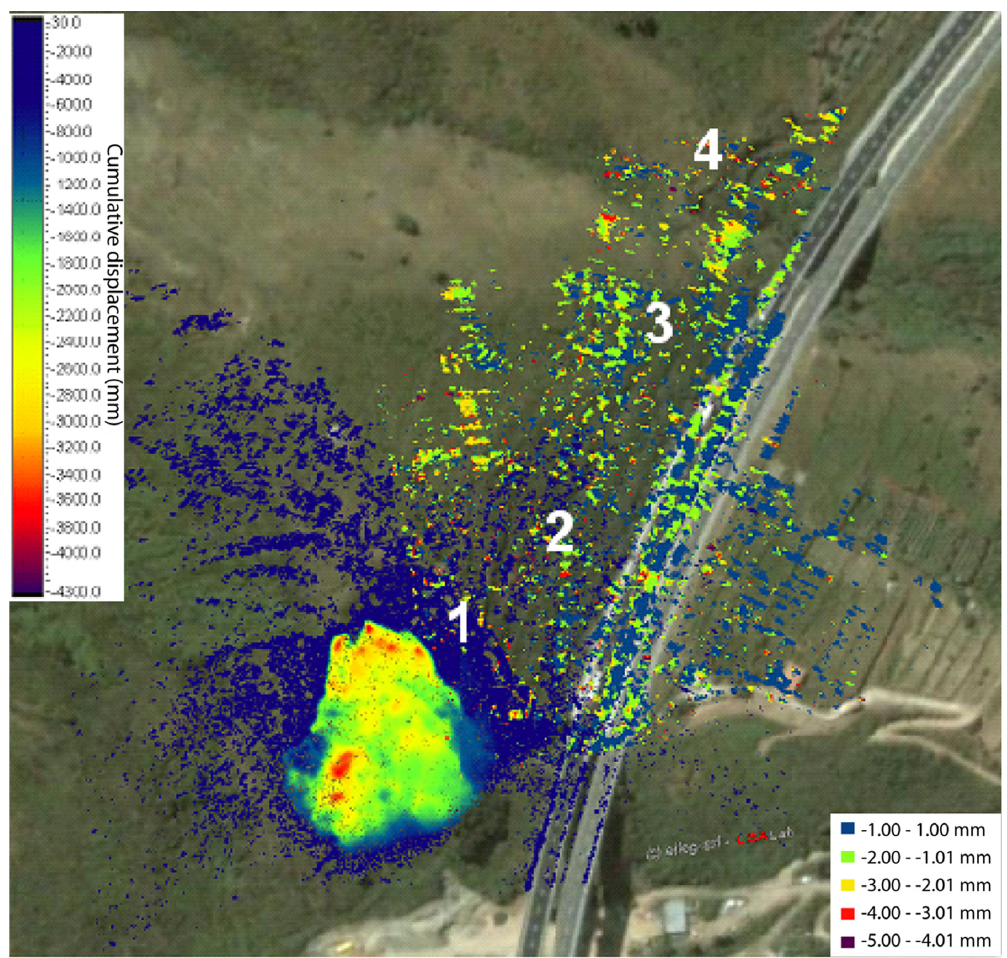
Fig. 12. Cumulated displacement map corresponding to 59 days (between 4 February and 4 April). Note that the scale bars used to represent the displacements of the two slopes are different: the scale bar on the left refers to the main slope, while the one on the bottom right refers to the NW slope. Both the scale are in